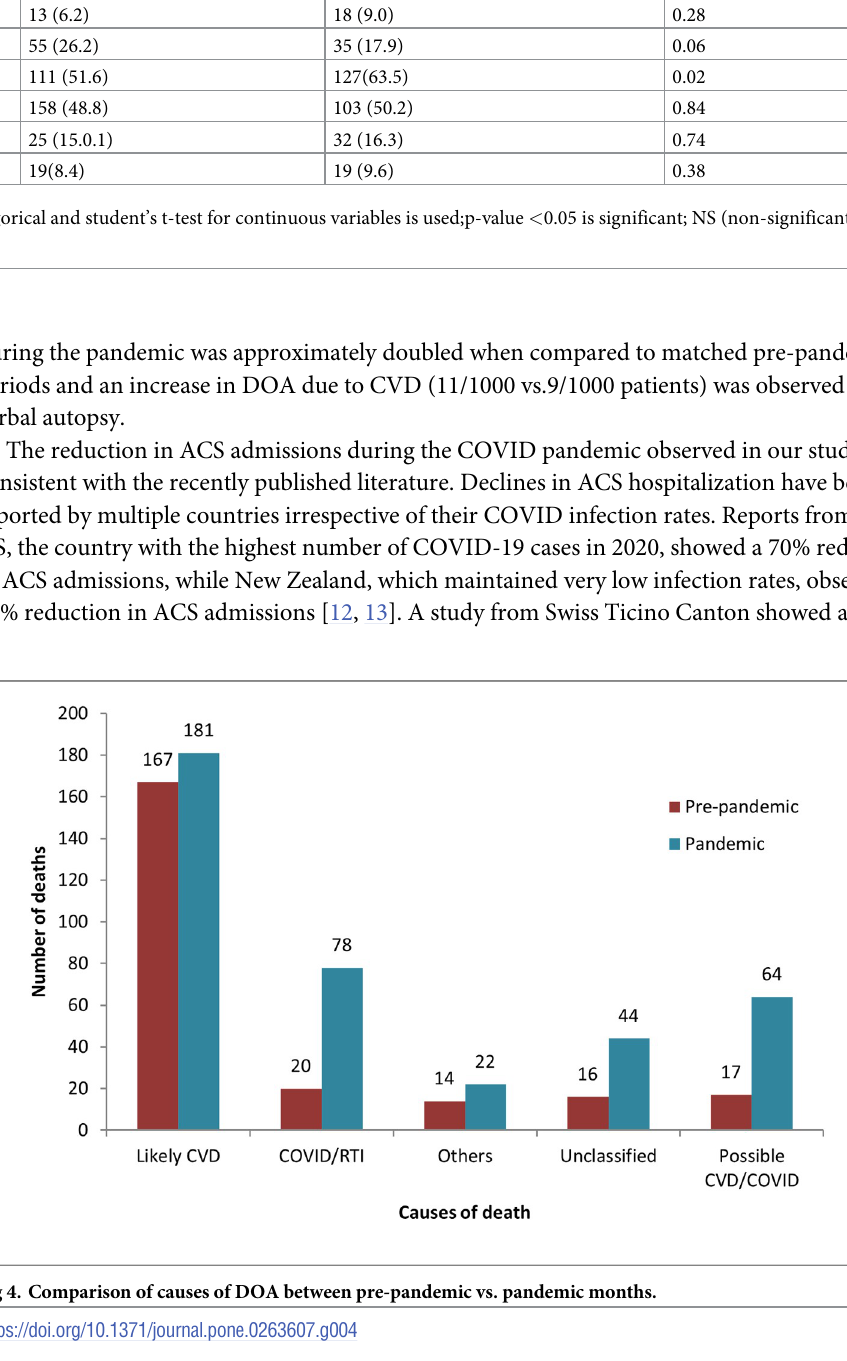
Table 4. Baseline characteristic of DOA during the pandemic and pre-pandemic era. Variables